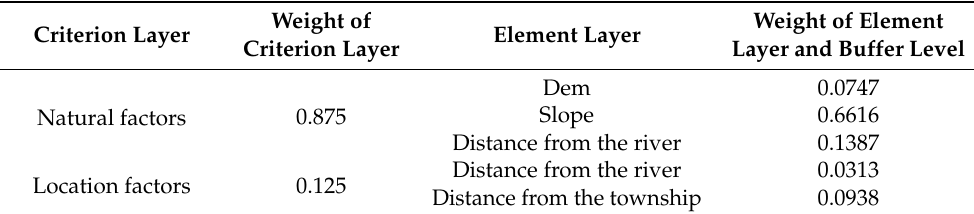
Table 3. Factors’ index